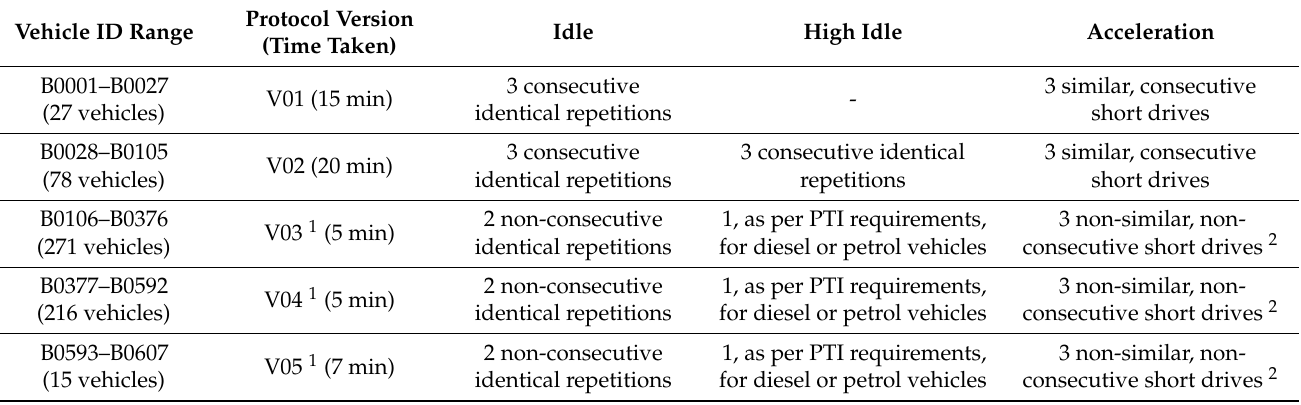
Table 1. Evolution of the enhanced PTI protocol over the course of the trial.